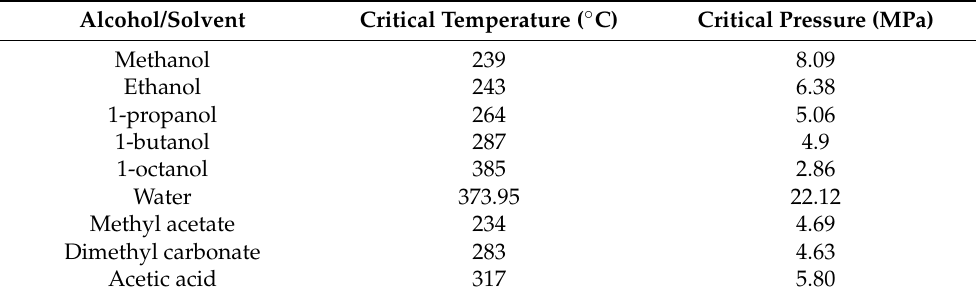
Table 8. Critical properties of various alcohols and other solvents [233–236].